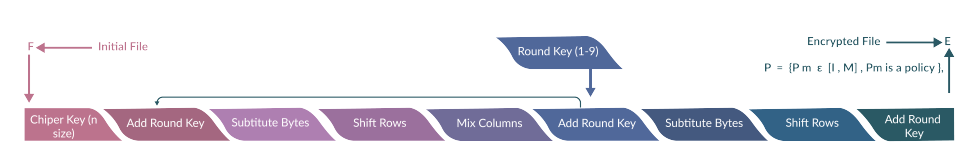
Figure 1. Data encryption with the AES